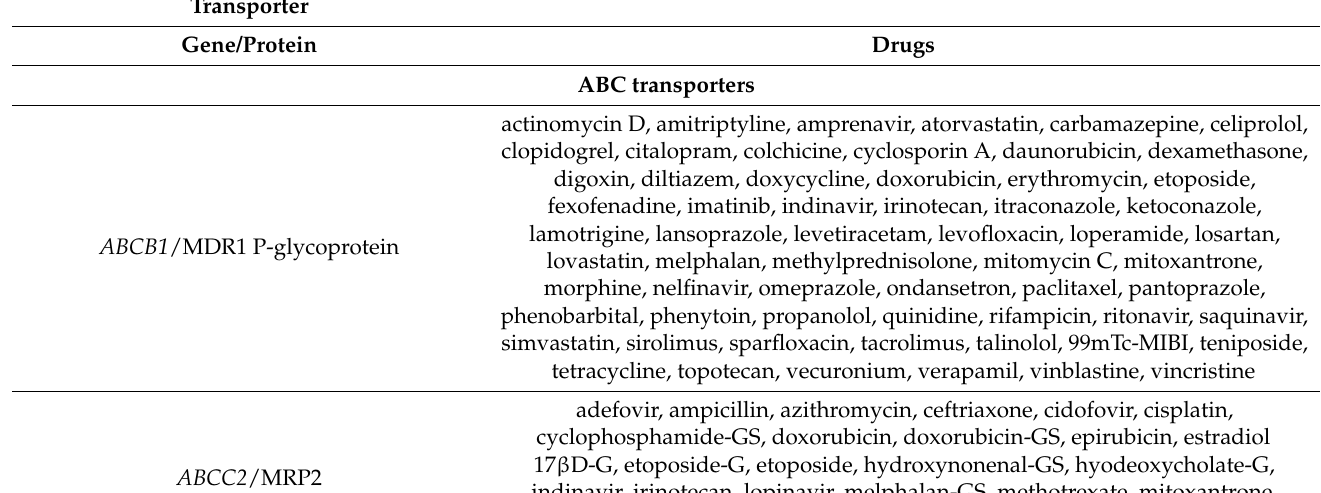
Table 1. Selected drug substrates of the principal renal transporters